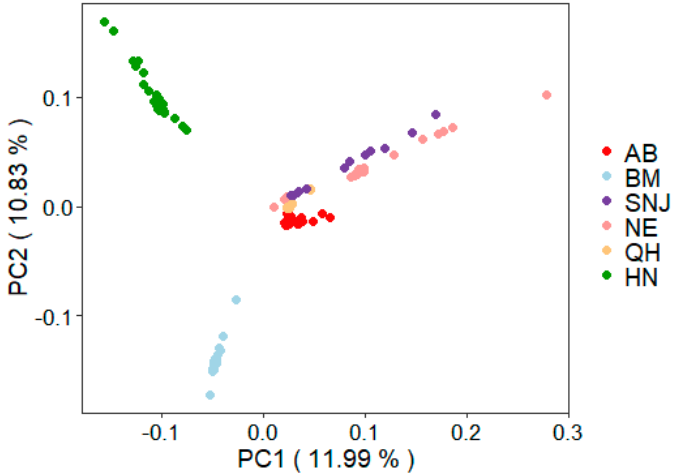
Figure 1. PCA plots of the 155 honeybee samples (the first two PCs). Honeybee samples were clustered by population groups (AB from Aba prefecture, Sichuan province; BM from Bomi, Tibet; SNJ from Shennongjia, Hubei province; NE from Liaoning, Jilin and Heilongjiang province; QH from Qinghai province; HN form Hainan Island).